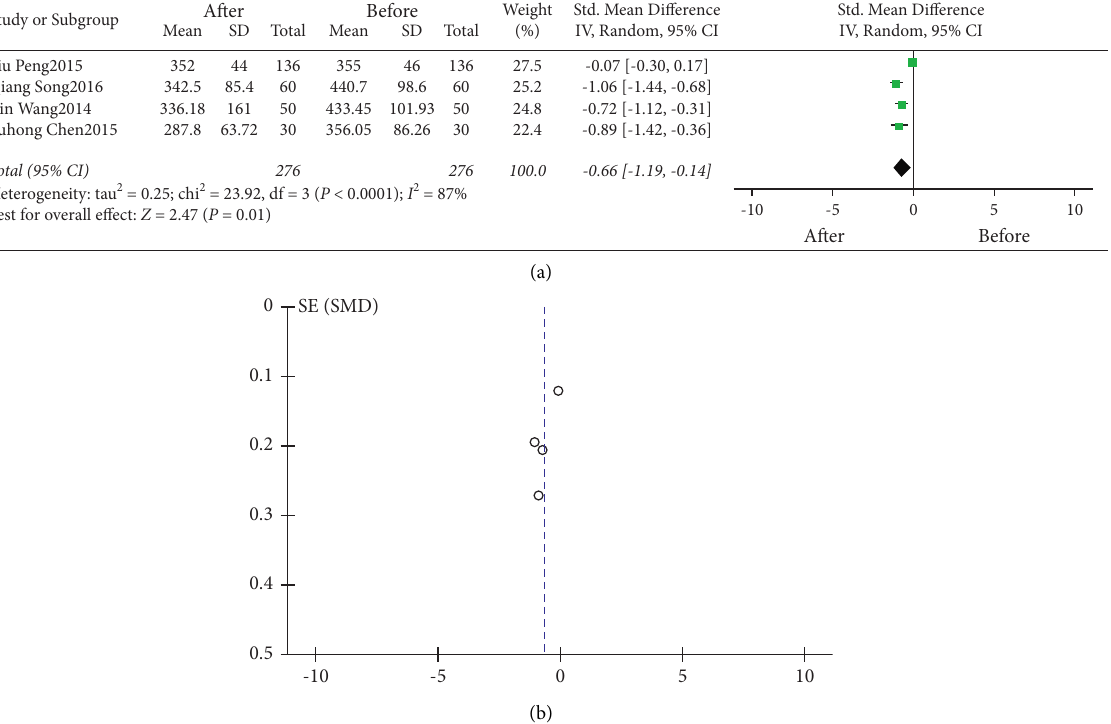
Figure 5: Relationship between SCH and serum UA levels before and after treatment. (a) Forest plot. (b) Funnel